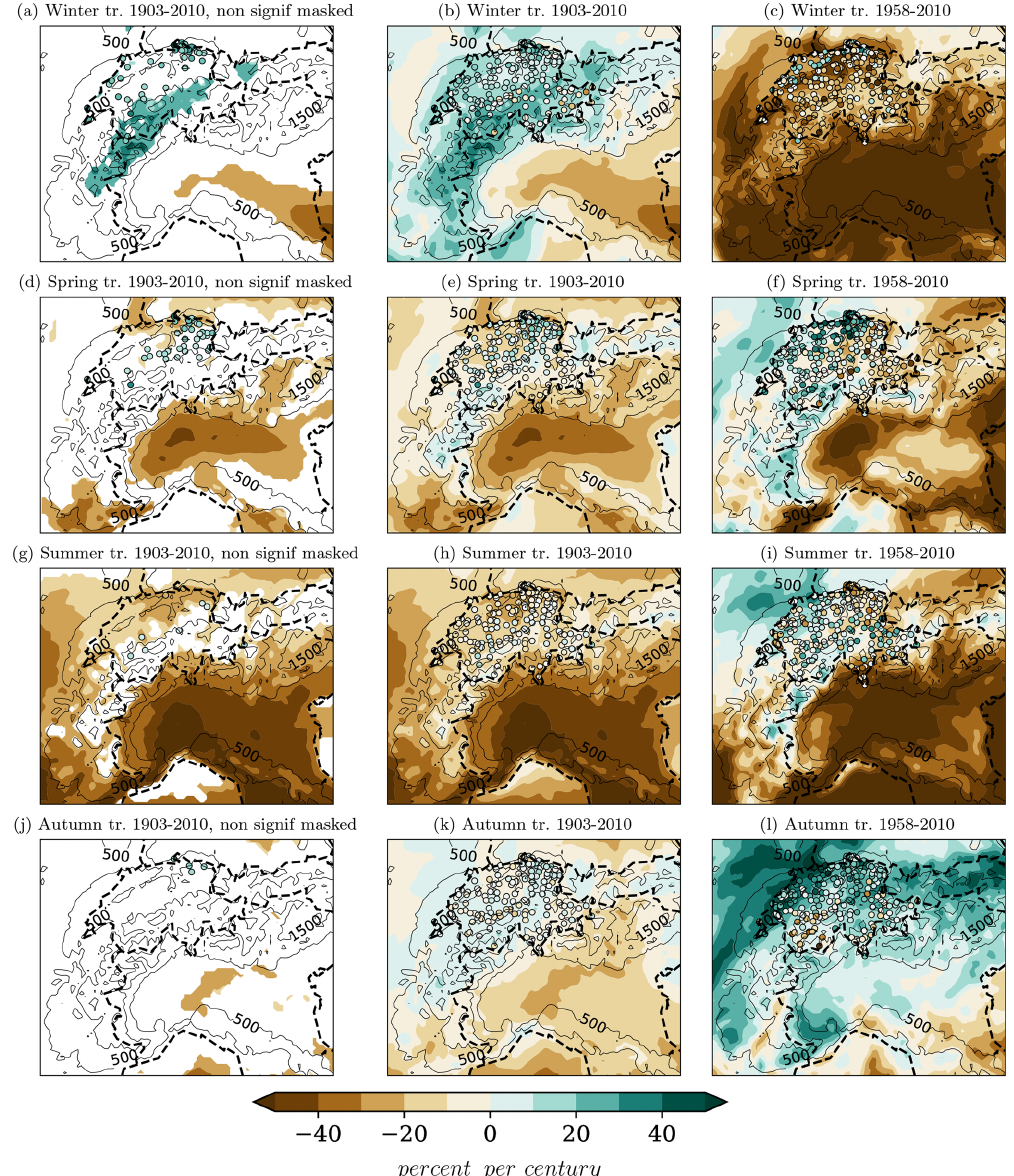
Figure 4. Seasonal linear trends (% per century) of precipitation in winter (a–c) , spring (d–f) , summer (g–i) and autumn (j–l) over 1903–2010 for (a, b, d, e, g, h, j, k) and over 1958–2010 for (c, f, i, l) . The 1000m spaced black contours show the topography in the 7km resolution model, starting from 500ma.s.l., and frontiers are denoted with the black dashed lines. In (a, d, g, j) , the trend is masked when its p value is below 0.05 (level of confidence lower than 95%; white areas for the model outputs and station data